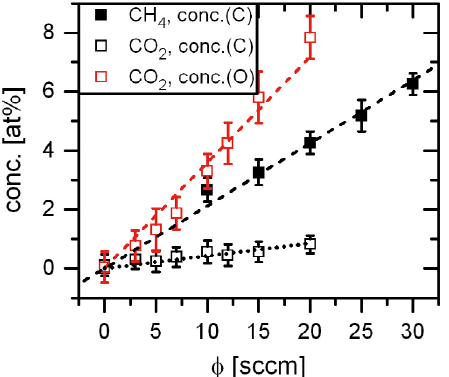
Fig. 3. C and O concentration from EBS of amorphous silicon alloy single layers against CH 4 or CO 2